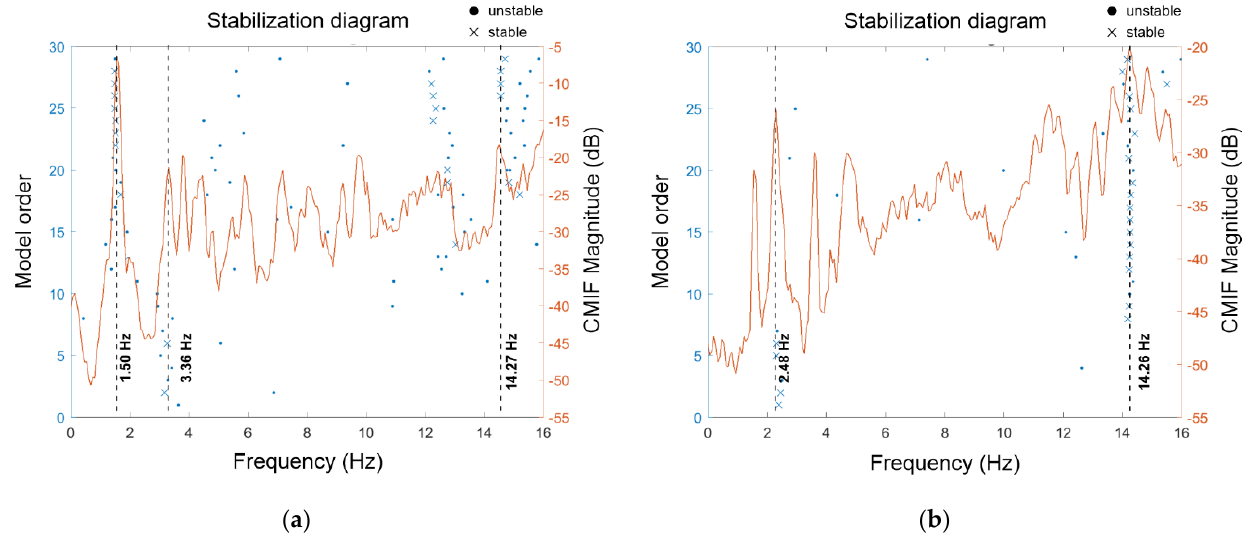
Figure 11. Stabilization diagram obtained using SSI algorithm for ( a ) the vertical, ( b ) the horizontal (transverse) acceleration registered during the in situ tests.